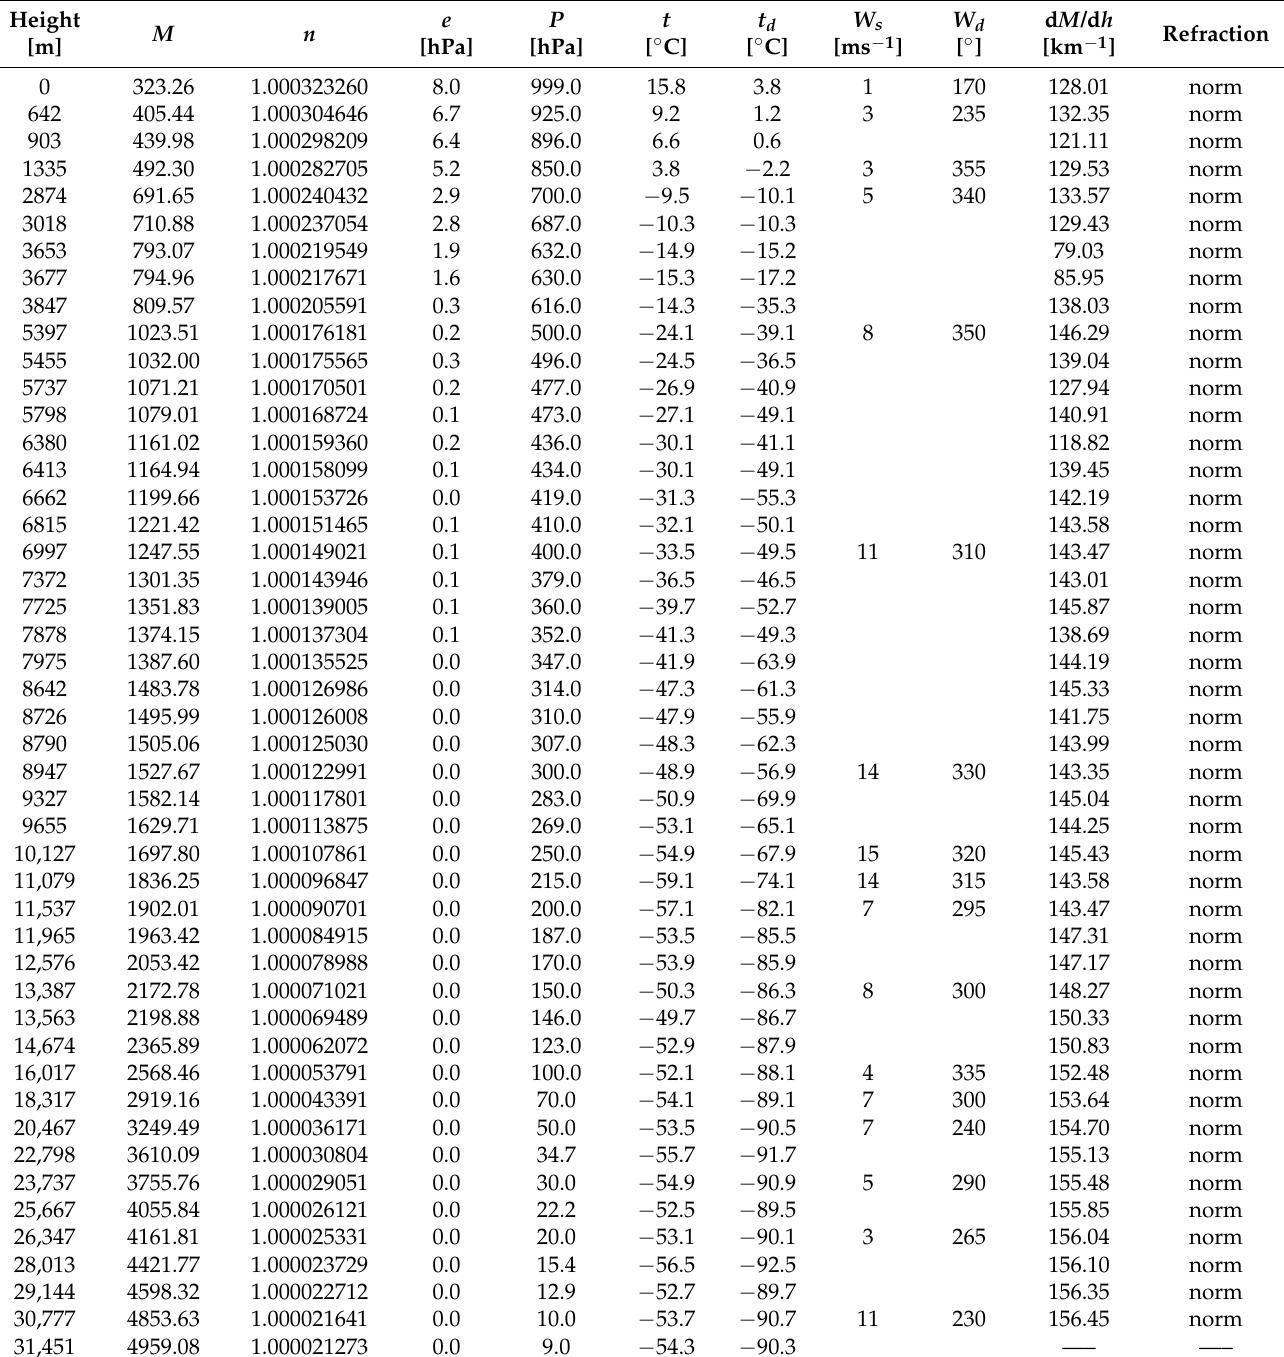
Table A2. Aerological soundings data and refractive profiles on 29 March 2020 at meteorological station Zagreb Maksimir (WMO index